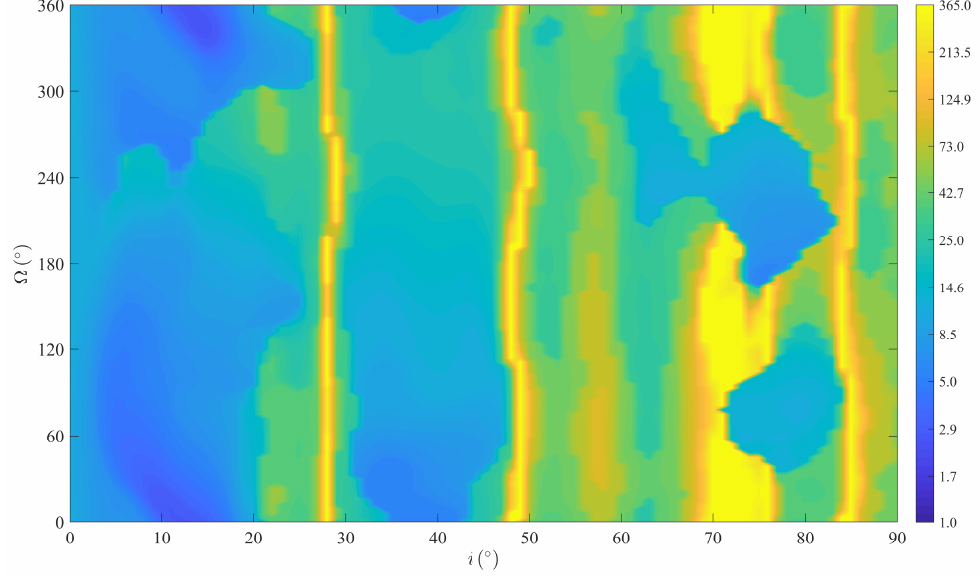
Figure 2. The lifetime of ultra low-altitude circular Lunar spacecraft with different initial inclination and